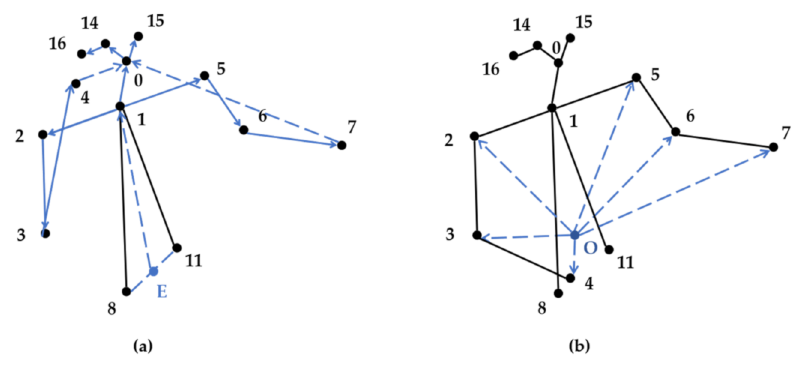
Figure 5. The human body structure vectors (the solid and dashed lines denote human skeleton and non-skeleton respectively, the blue line represents the human body structure vectors) ( a , b